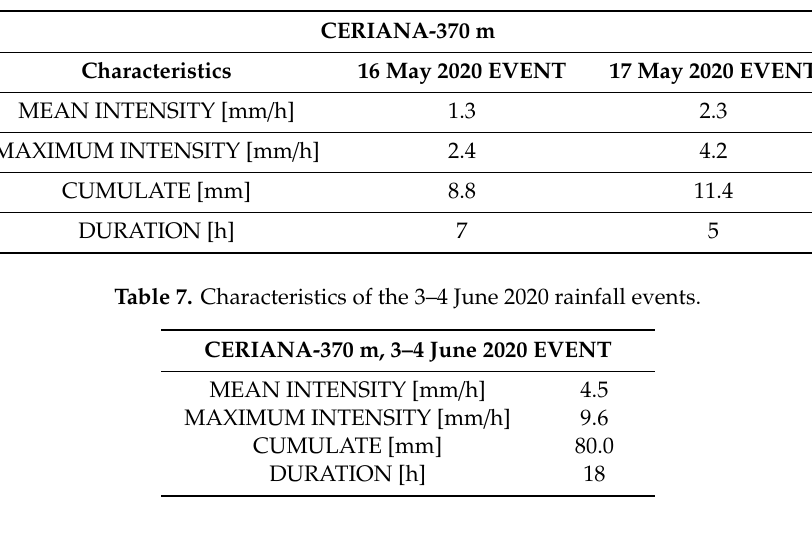
Figure 19. C5 node: ( a ) Node identification and warning signboard; ( b ) Carrying and rising pole of both the Sensor Pup and the solar panel; ( c ) Soil sampling. Table 6. Characteristics of the 16–17 May 2020 rainfall events.